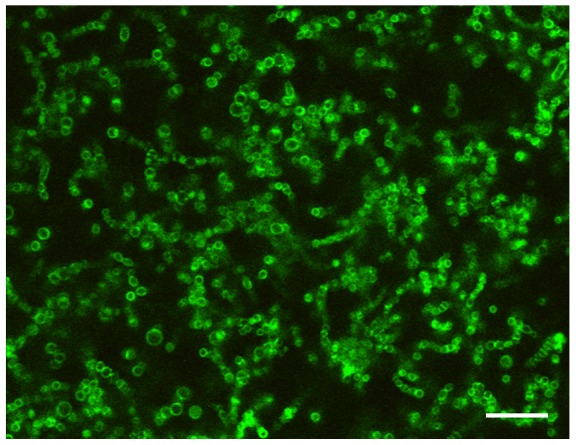
Binding of OPN to bacteria in the biofilms.After growth phase, a biofilm was incubated with fluorescently labelled OPN for 45 min at 35°C. OPN (green) bound to bacterial cell surfaces. Note that chains of streptococci can be recognized, although no bacterial stain was used. Bar  = 10 µm.